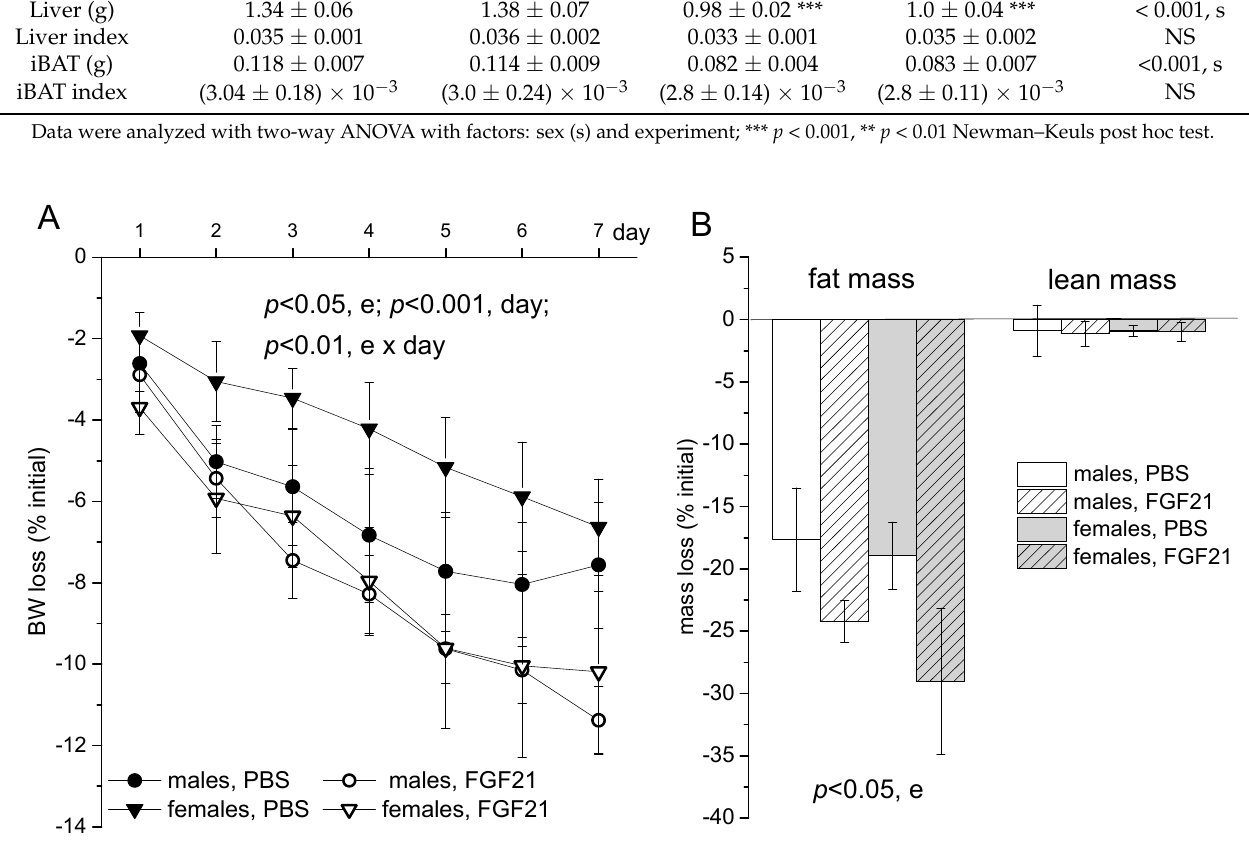
Figure 1. Influence of FGF21 administration on BW ( A ) and lean and fat masses ( B ) in obese male and female C57Bl mice. Data are presented as mean ± SEM. Mice were administered FGF21 for 7 days, and weight loss was calculated as % of initial BW. A: significant influence of factor “e” (experiment: administration of PBS or FGF21), “day” (7), and e × day, repeated measures ANOVA; B: significant influence of factor “e”, two-way ANOVA with factors “experiment” and “sex”.